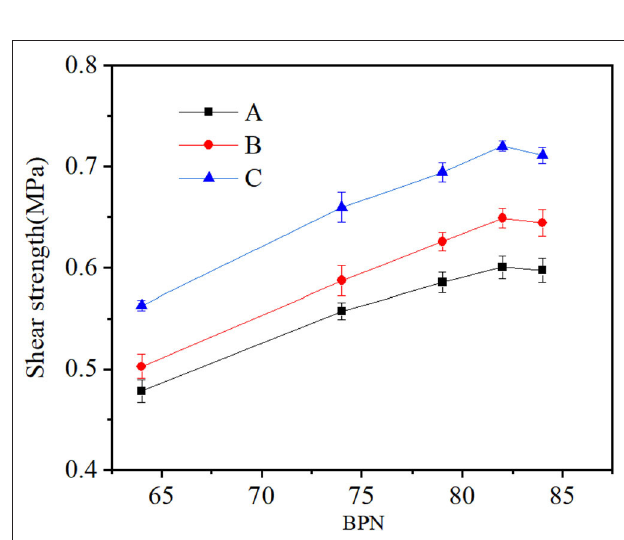
FIGURE 10 | Relation between groove interval and BPN value.